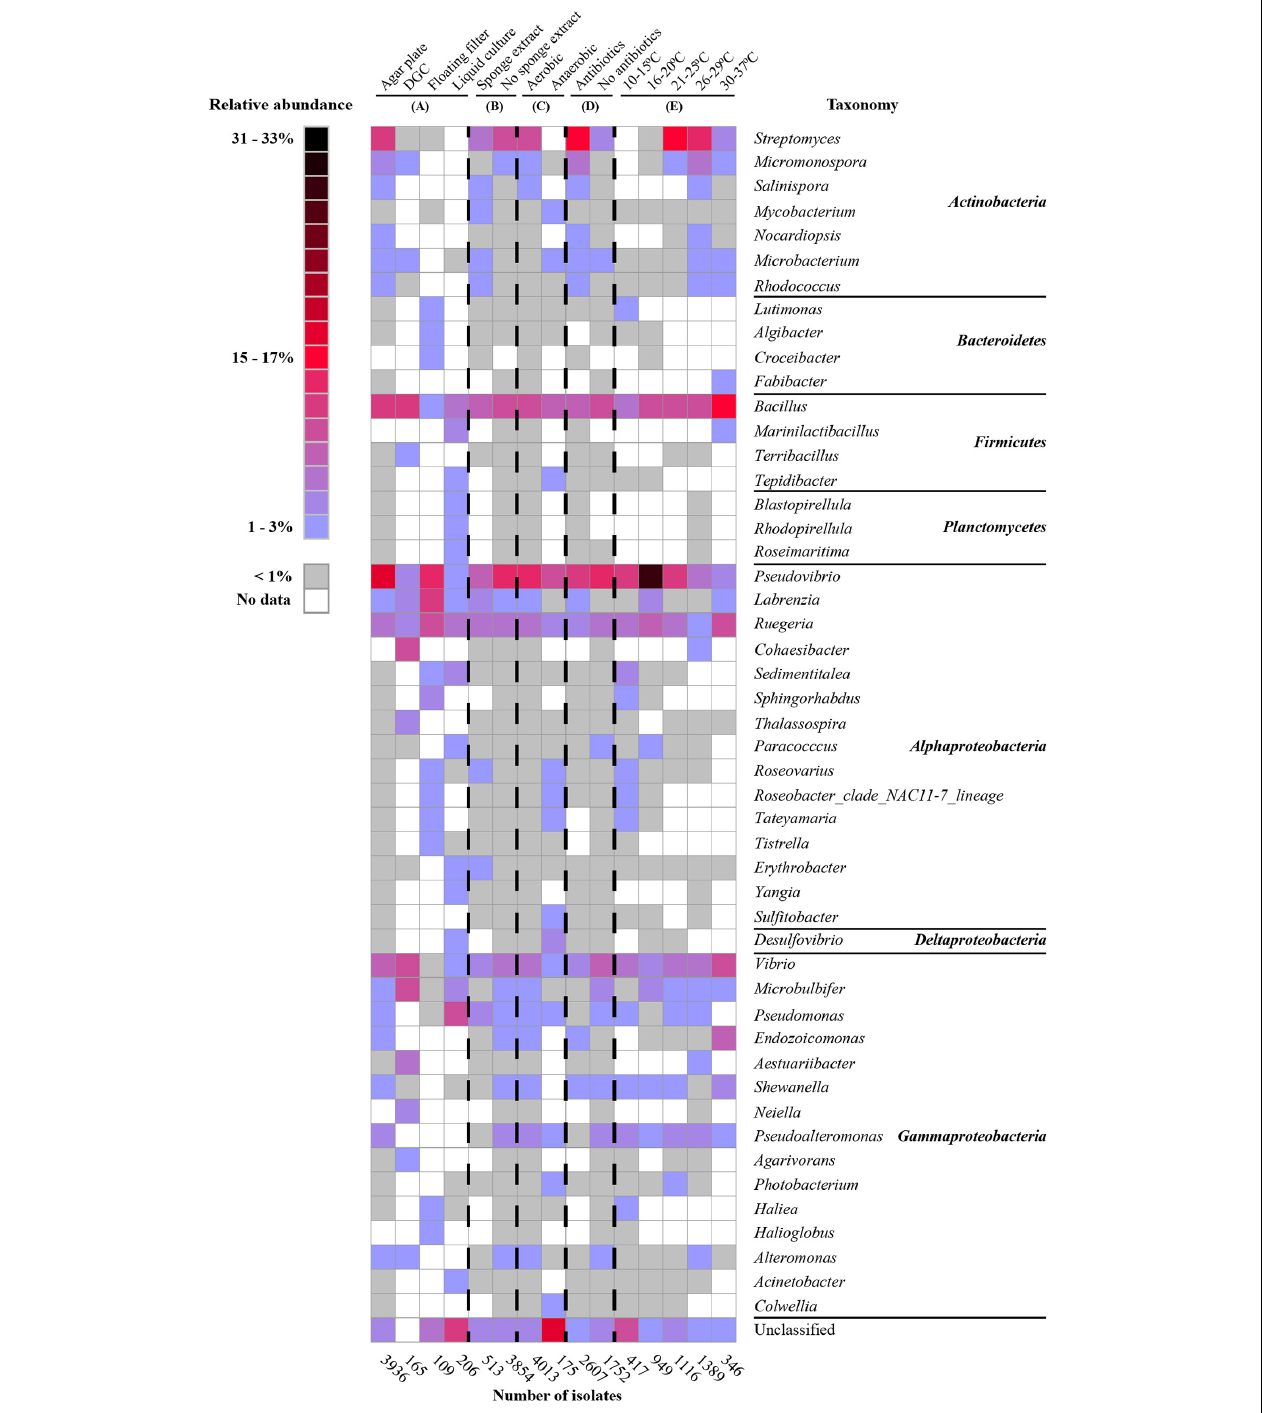
FIGURE 3 | Heat map of the most abundant genera (50 genera) under different cultivation conditions: isolation methods (A) , with/without sponge extracts in culture media (B) , with/without oxygen (C) , with/without antibiotics in culture media (D) , and temperatures (E) . The percentages in the heatmap were calculated for each of the categories (sum for each column is